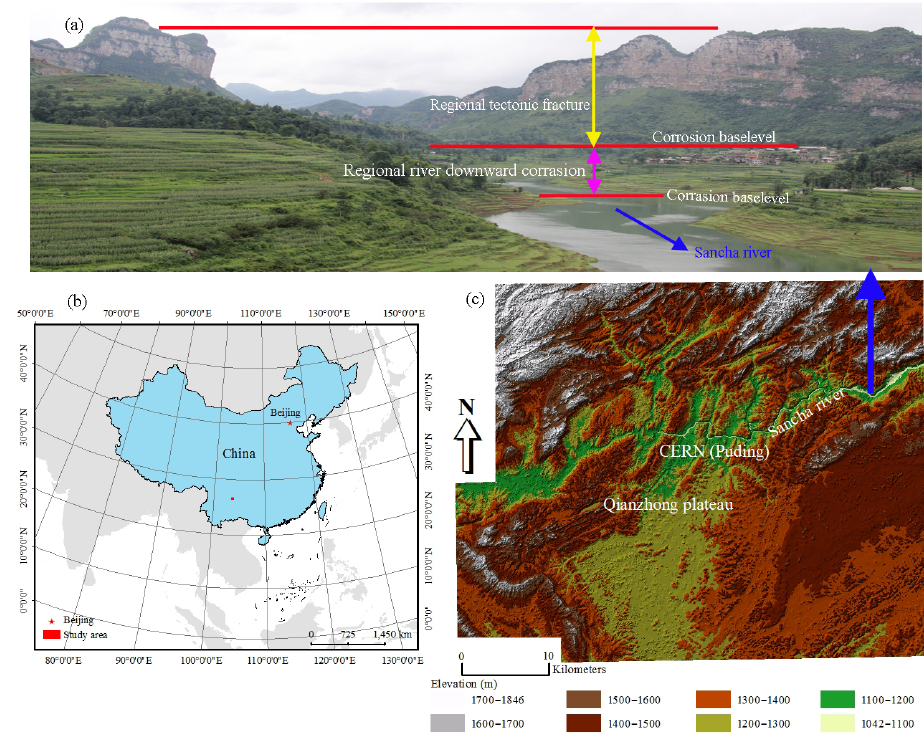
Figure 1. Location and topography of the study area. (a) Is the general view of Sancha river, (b) is the location of the study area and (c) is the elevation map of the study